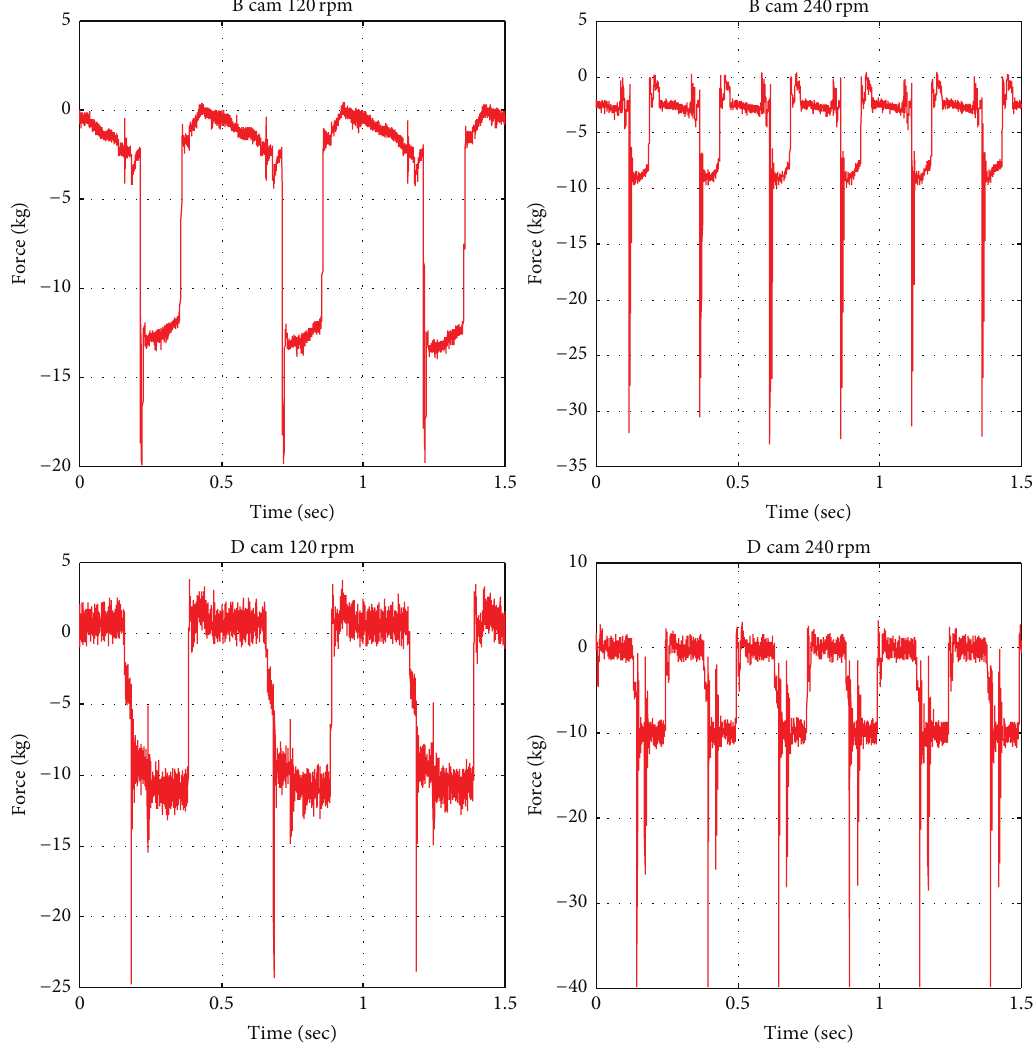
Figure 6: Forces experienced by the fixtures B and D for two different speeds.